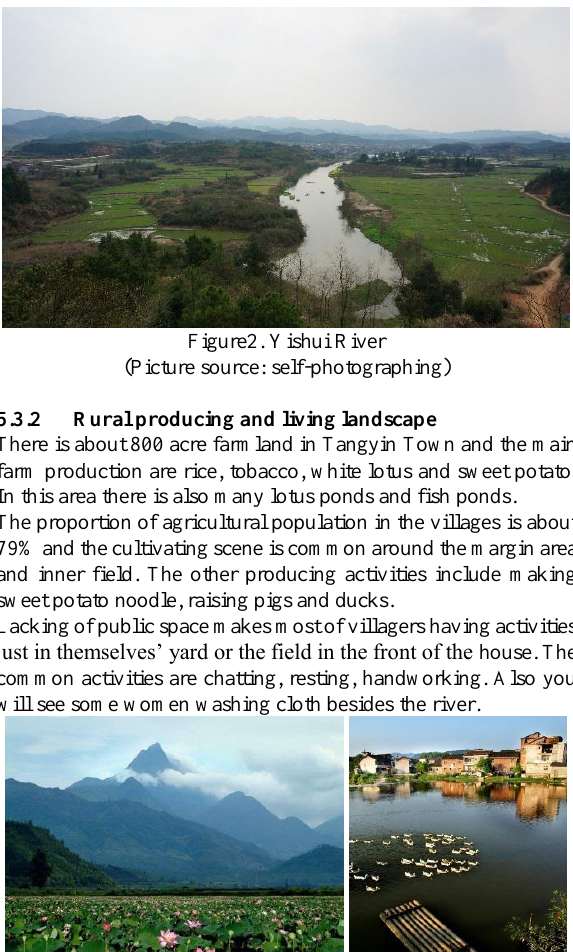
Figure3. Ponds In The Villages (Picture source:download from www.baidu.com)